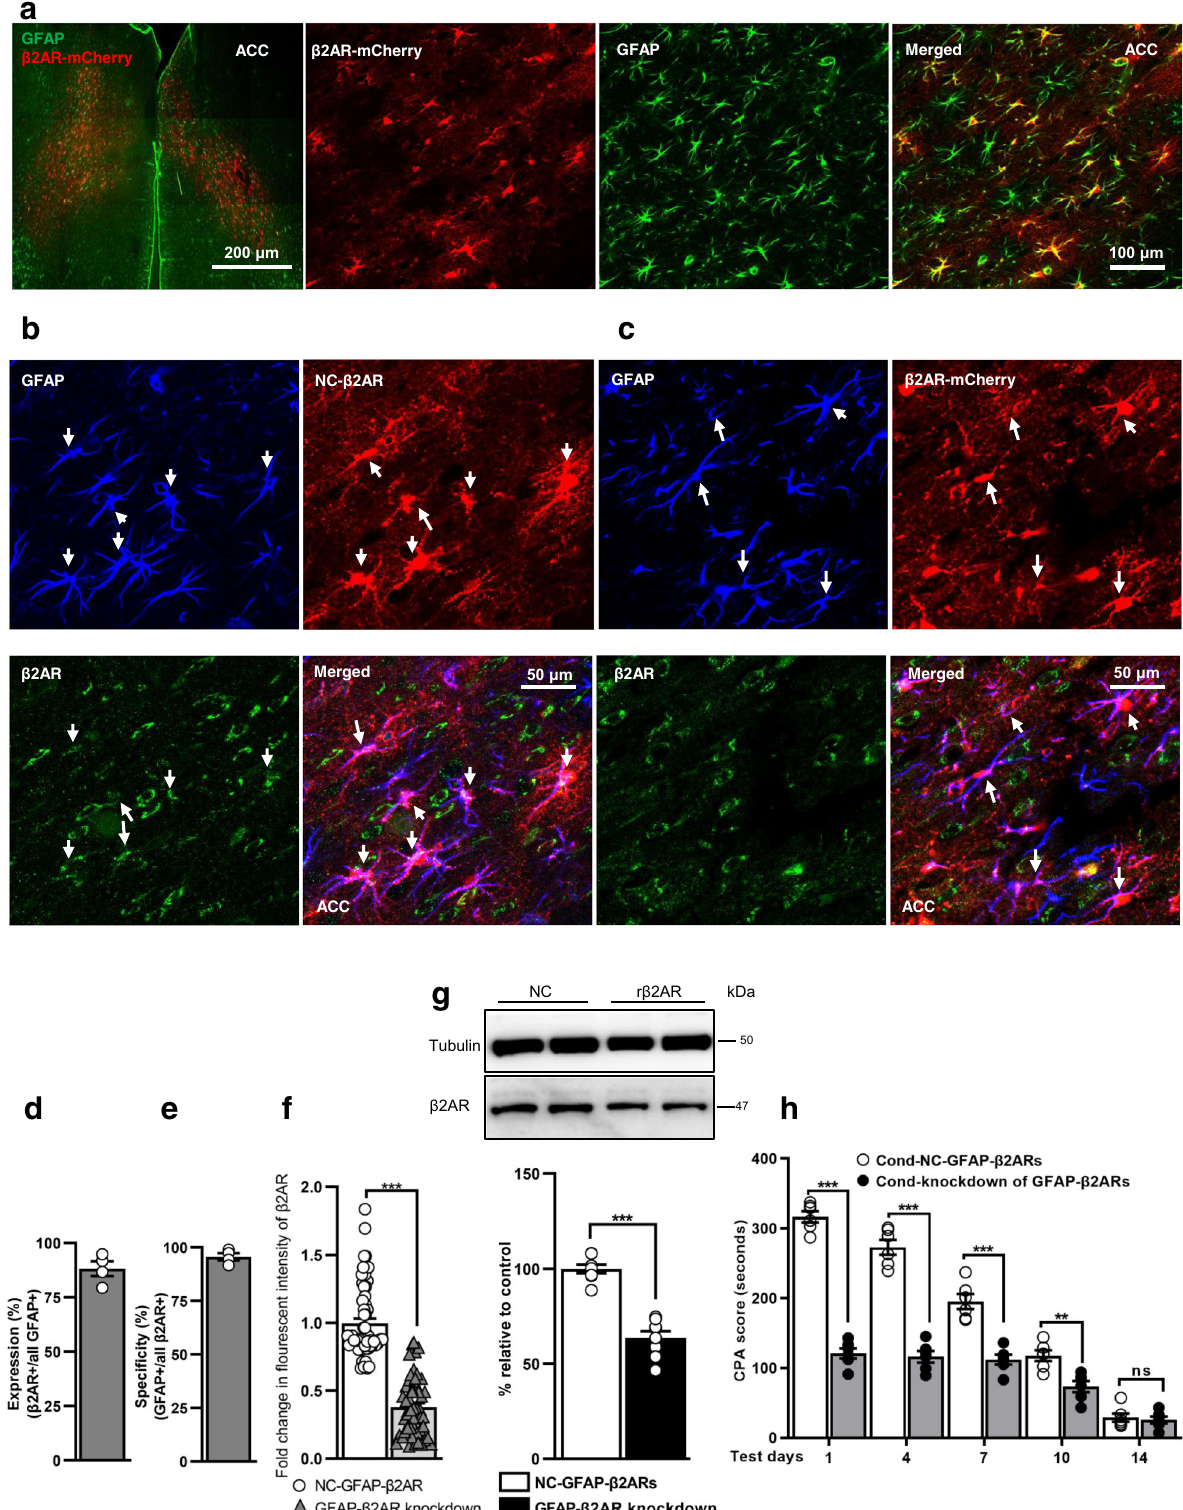
memory formation. Our results are consistent with previous fi ndings concerning the function of astrocytic β 2ARs 60 . Gao et al. 60 found that shRNA-mediated knockdown of β 2AR in astrocytes but not in neurons in HPC impaired inhibitory avoidance long-term memory 60 . However, as ACC consists of several types of neurons, including excitatory